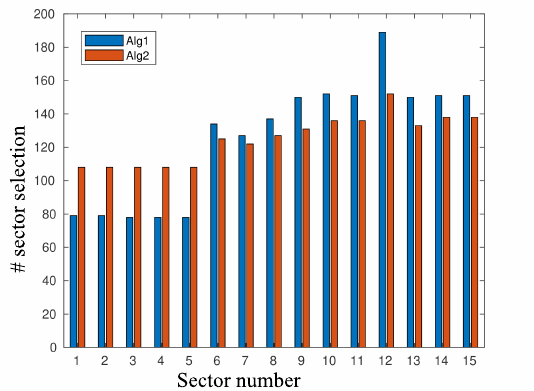
Figure 13. Sector selection distribution, where sectors 1–5 are subject to blockage with β = 5.